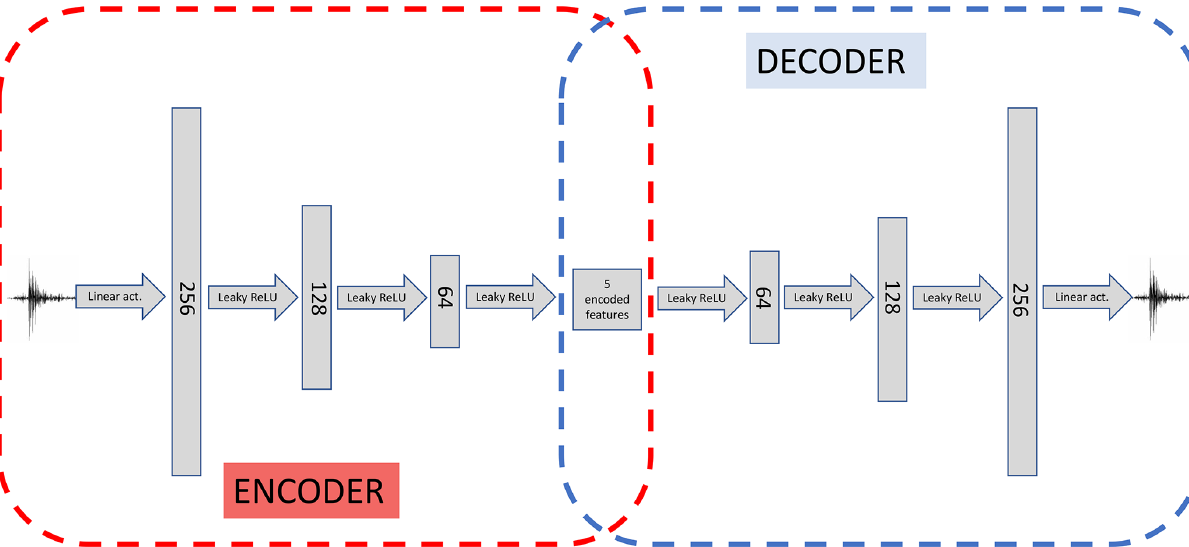
Figure 4. Typical architecture of an autoencoder. A bottleneck architecture allows for the compression of the input signal into a central layer through the “encoder” part of the network (in red). The central layer is characterized by fewer nodes than the input one, thus leading to dimensionality reduction on condition that the “decoder” part (in blue) can efficiently reconstruct the input signal (to a good degree of accuracy) starting from the central encoded features. In this schematic we highlight that training of the autoencoder is performed by feeding a seismogram to the encoder, and then comparing the output of the decoder with the same input seismogram. Once the autoencoder has been trained, the encoder can be removed, and the decoder can be used as a generative model for the seismograms, inputting some encoded